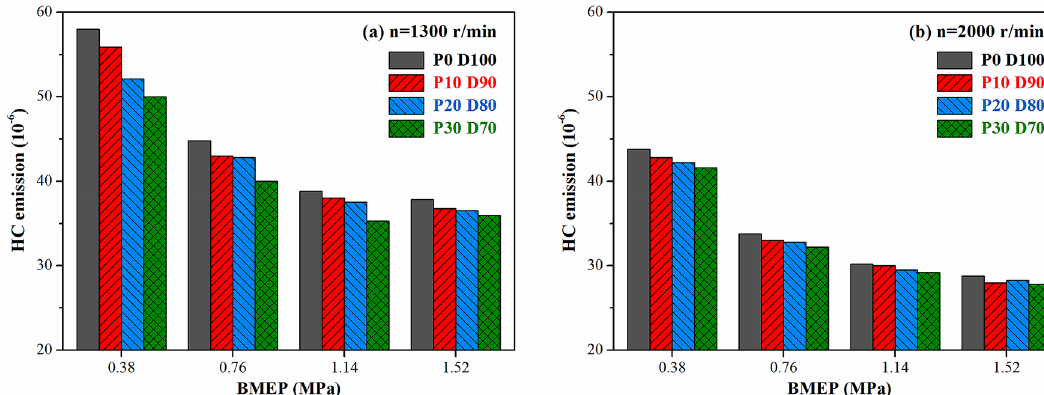
Figure 10. Effects of PODE n blending ratio on HC emission.